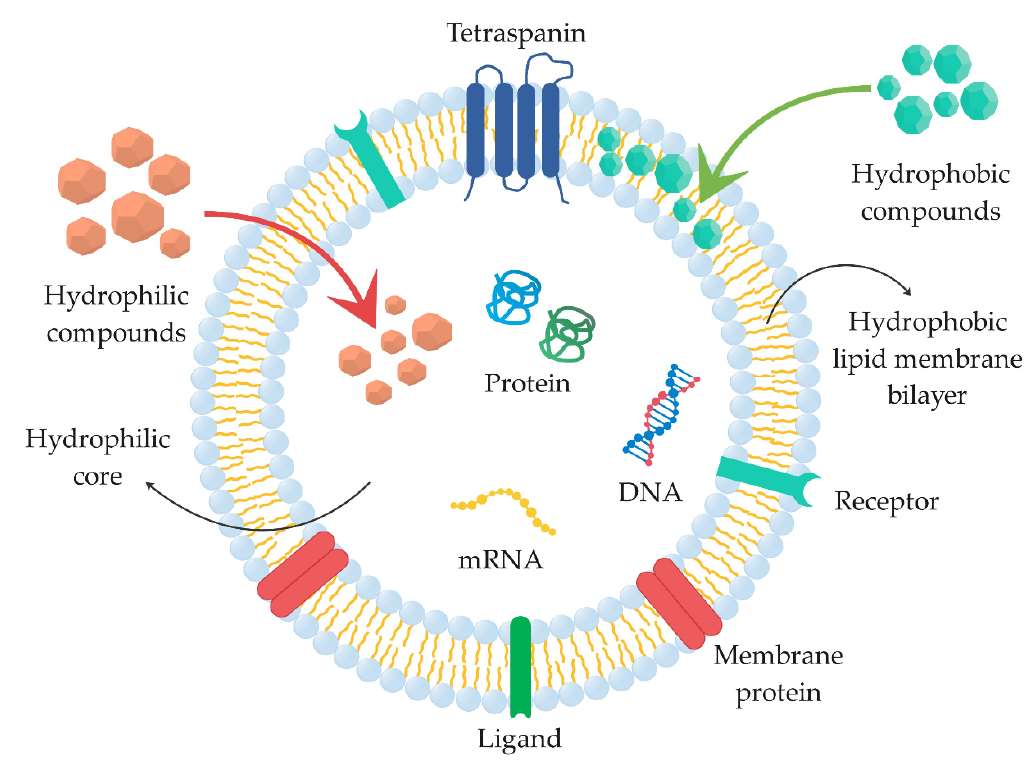
Figure 10. Incorporation of hydrophilic (e.g., melatonin, gemcitabine, linezolid, vancomycin, and lysostaphin) and hydrophobic (e.g., curcumin, paclitaxel, doxorubicin, and aspirin) cargo into hydrophilic core and hydrophobic lipid membrane bilayer of exosomes (summarized from [7,76,84,85,100,102,104–110]).